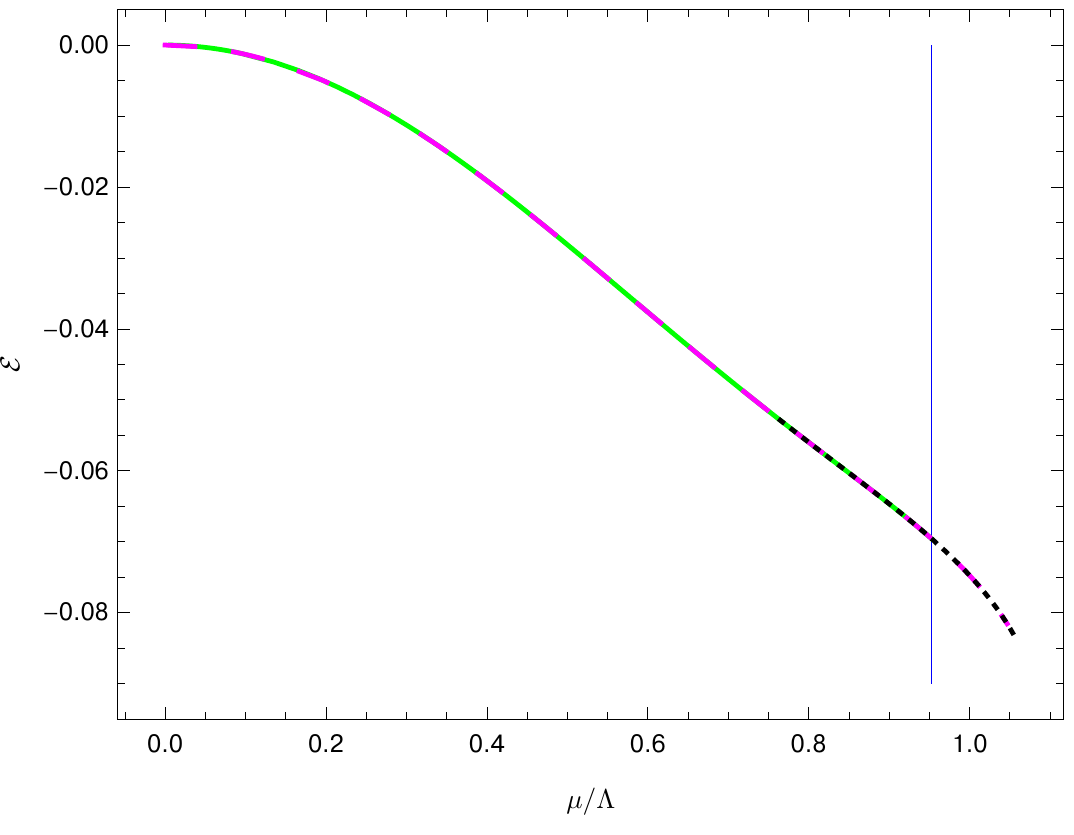
Figure 10 . Cross checks on numerics of vacua energy in the three different computational V B schemes: solid green curve, dashed magenta curve, and the dotted black curve. The vertical blue line denotes the common reference point in the green/black curve computational schemes, see